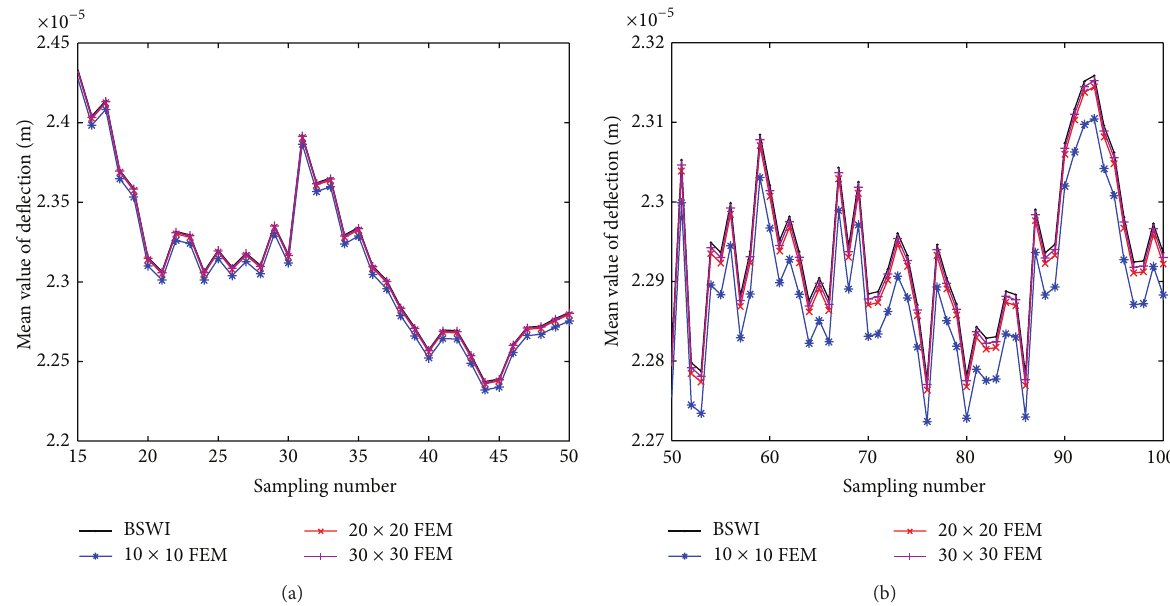
Figure 13: Relationship between the mean value of plate center deflection and sampling number: (a) sampling number 15–50, (b) sampling number